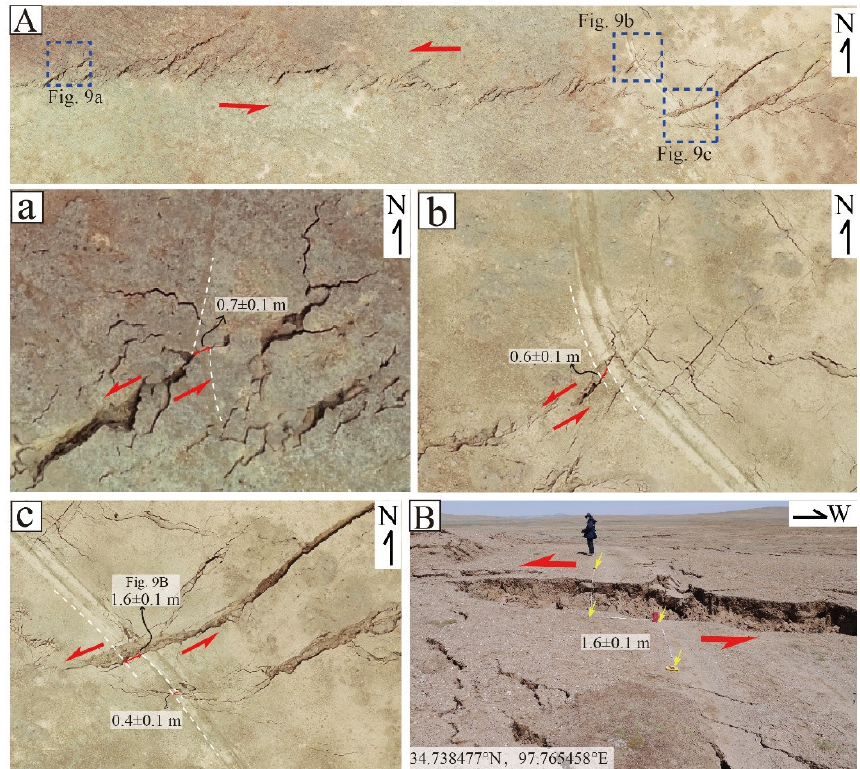
Figure 9. ( A ): Orthophoto of surface rupture and left-lateral offsets along the south Eling Lake; ( a – c ): left-laterally displaced rut prints on the grassland; ( B ): field photo showing left-lateral displaced rut prints on the grassland of the site on ( c ).